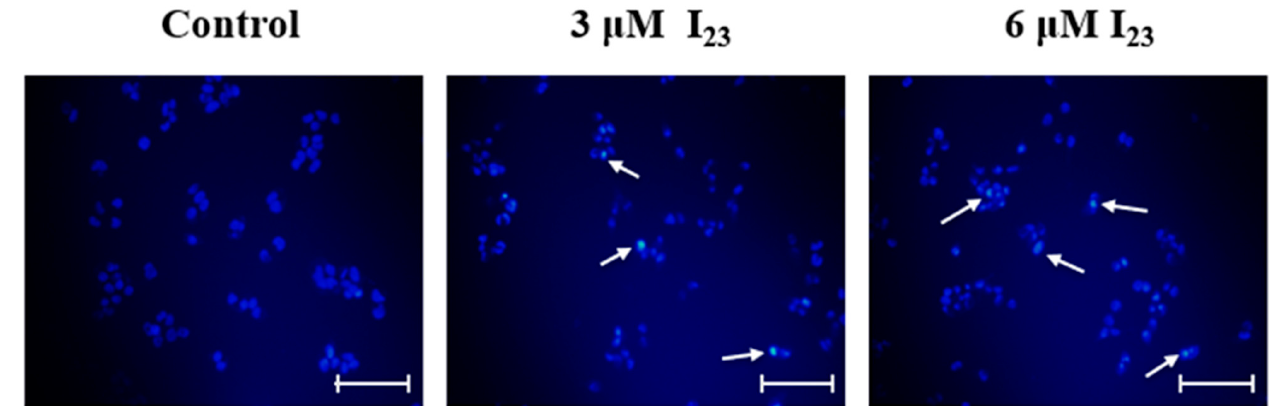
Figure 9. The cells were incubated with 0 µ M, 3 µ M and 6 µ M compound I 23 for 24 h, subsequently stained with Hoechst 33258 (10 μ g/mL) and visualized by fluorescence microscopy. Scale bars are 100 μ m.